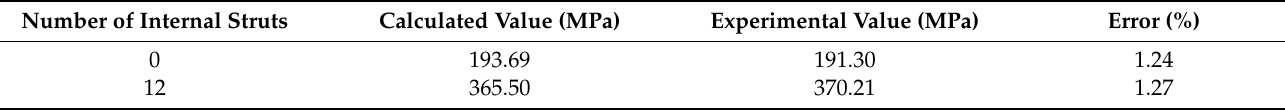
Table 6. Comparison of calculated and experimental values.